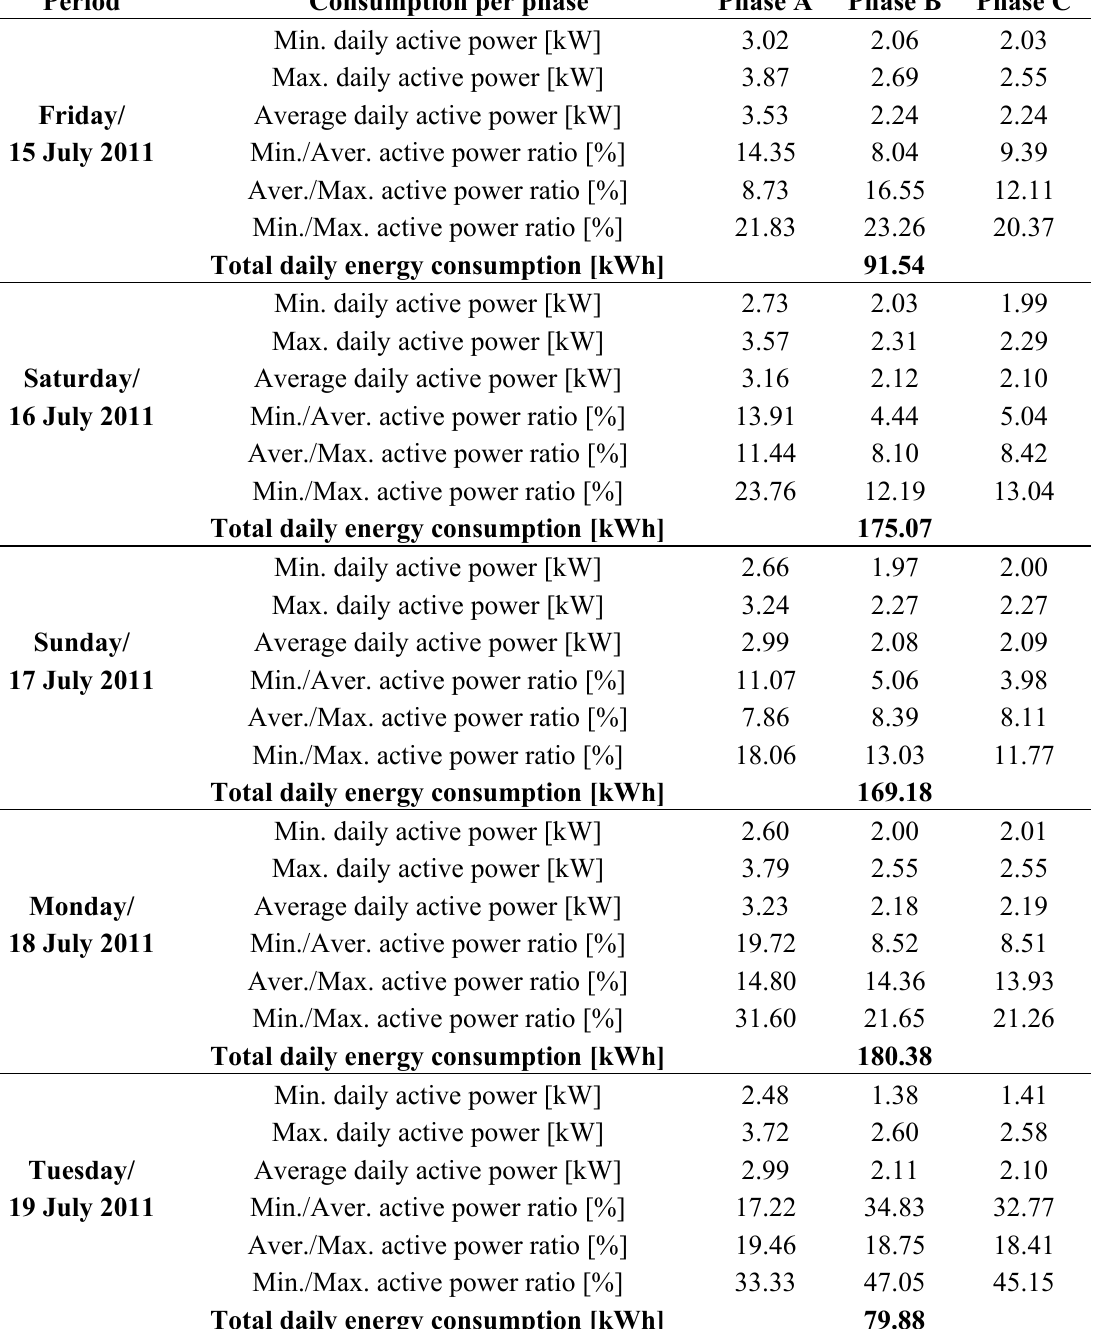
Table 3. Statistics of the AC daily active power consumption.